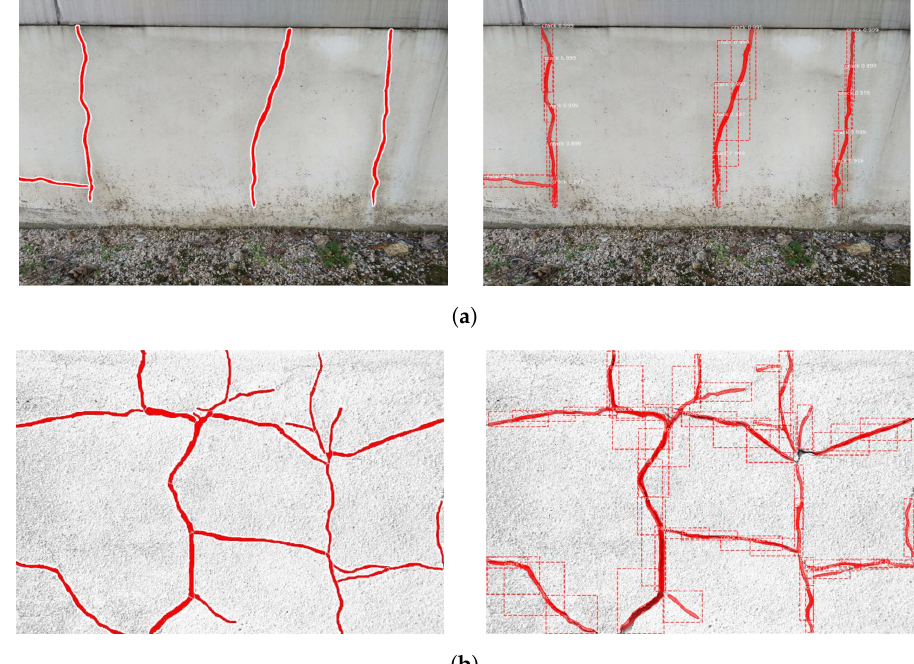
Figure 5. Examples of crack detection results (left column: original images with ground truth, right column: detection result of trained Mask R-CNN): ( a ) detection result of Crack-1 in Table 1, and ( b ) detection result of Crack-3 in Table 1.